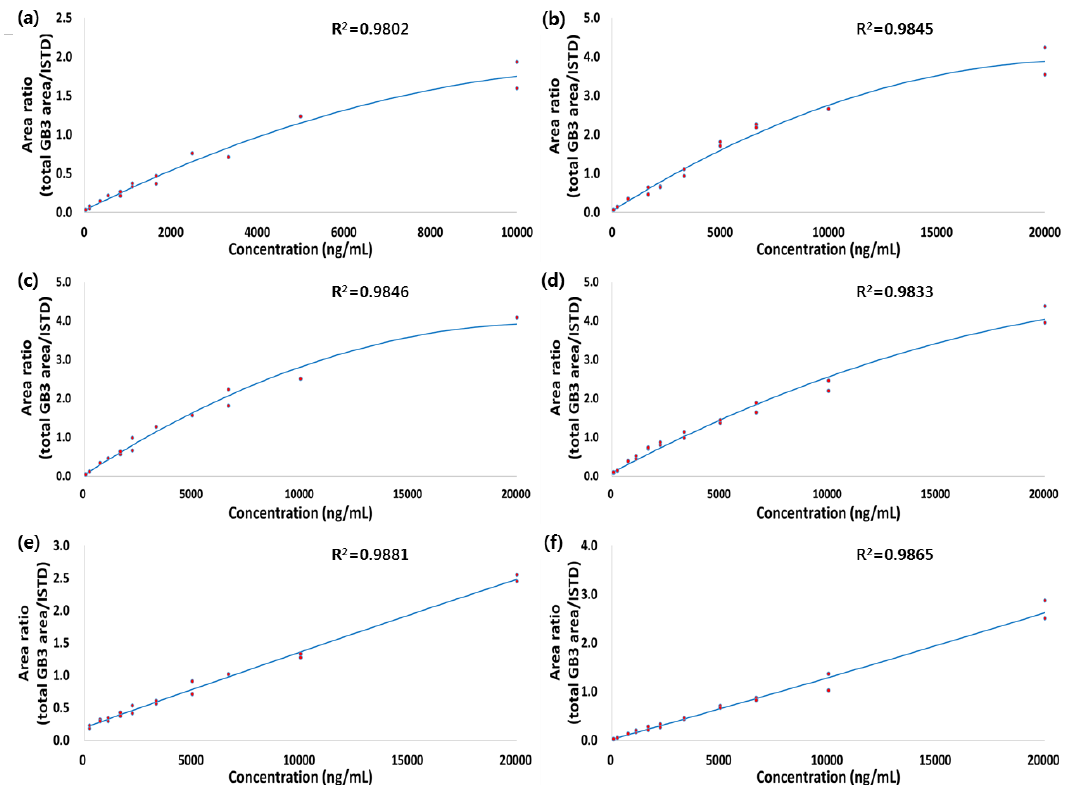
Figure 5. Calibration curve of GB3 in ( a ) plasma; ( b ) heart; ( c ) liver; ( d ) spleen; ( e ) kidney; and ( f ) brain.